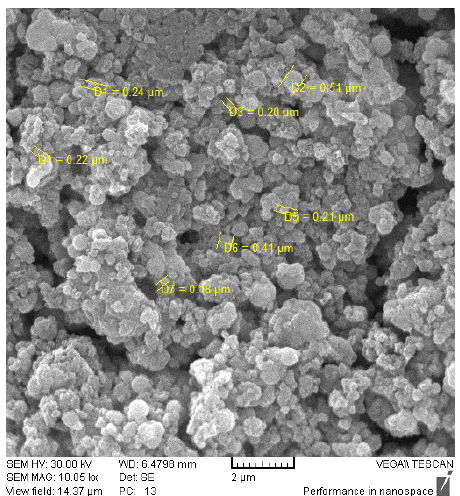
Figure 4. Figure caption.The SEM image of Fe@Co-Al LDH, with the size of